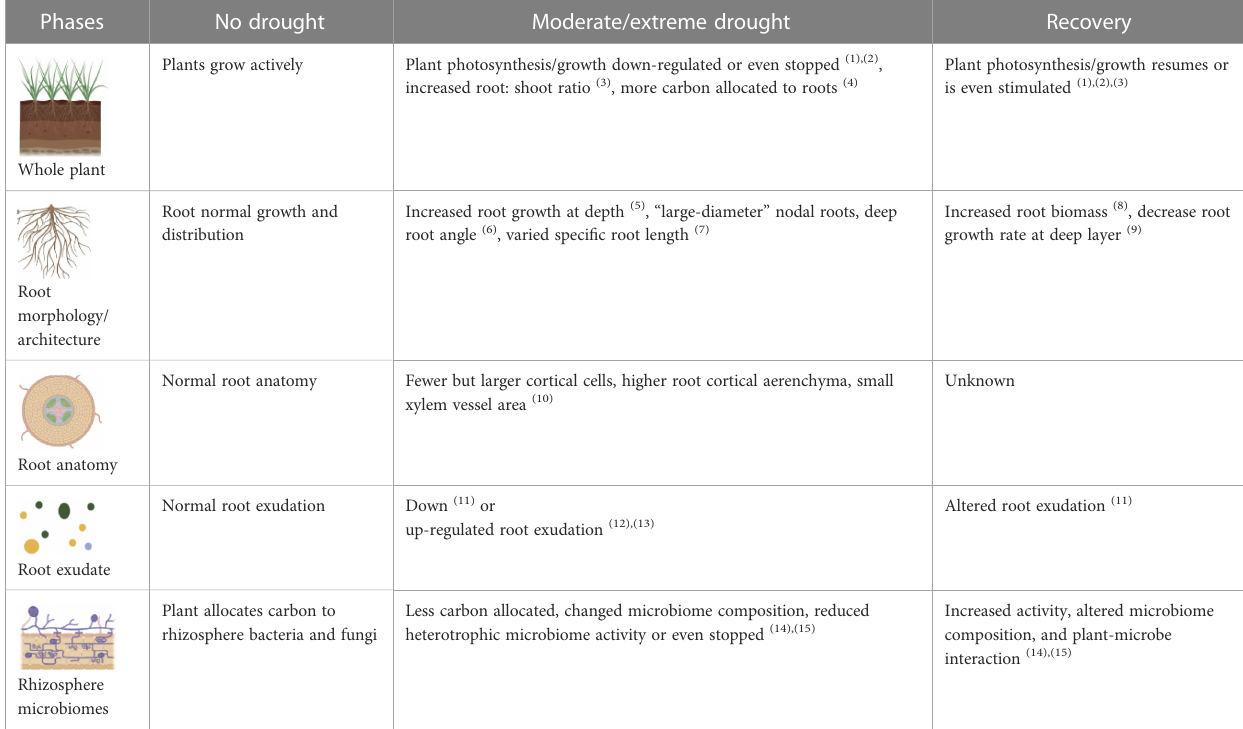
TABLE 6 Overview of root plasticity during drought and recovery